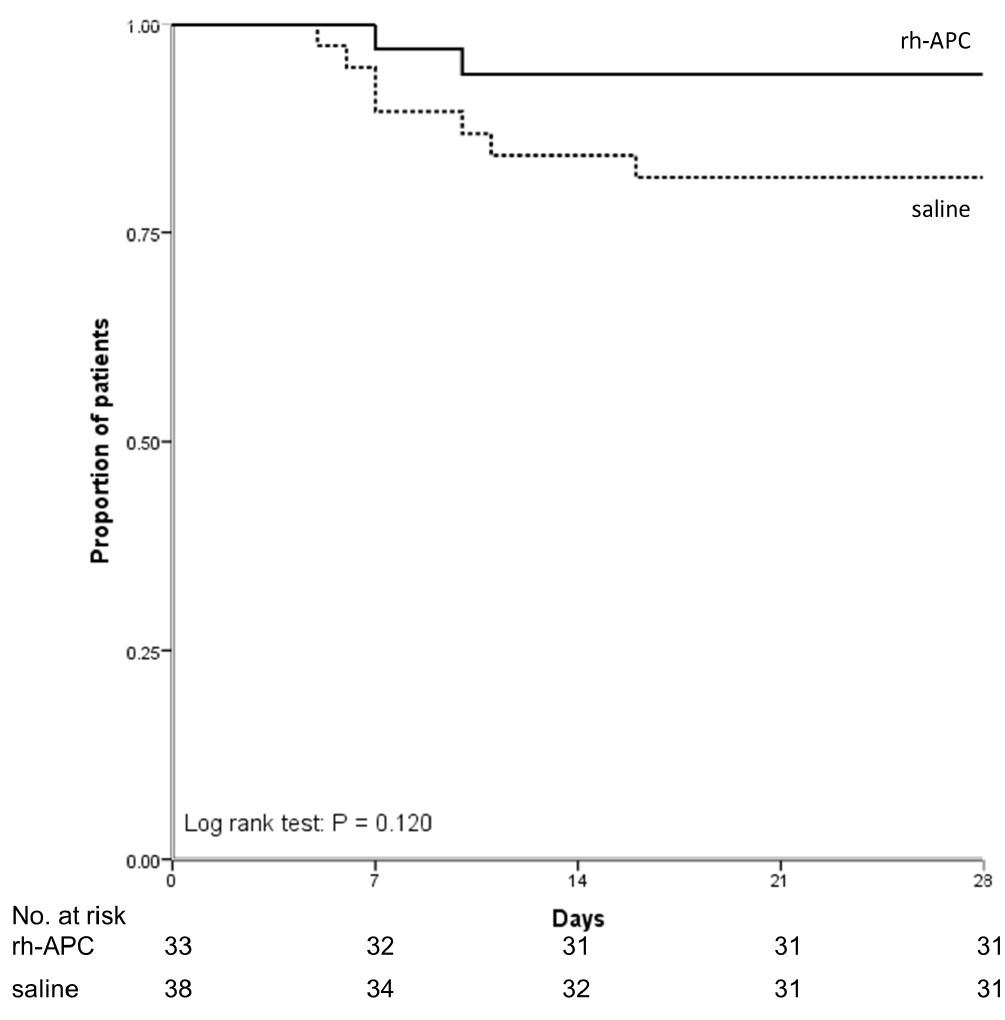
Figure 3. Probability of survival until day 28 in study groups.